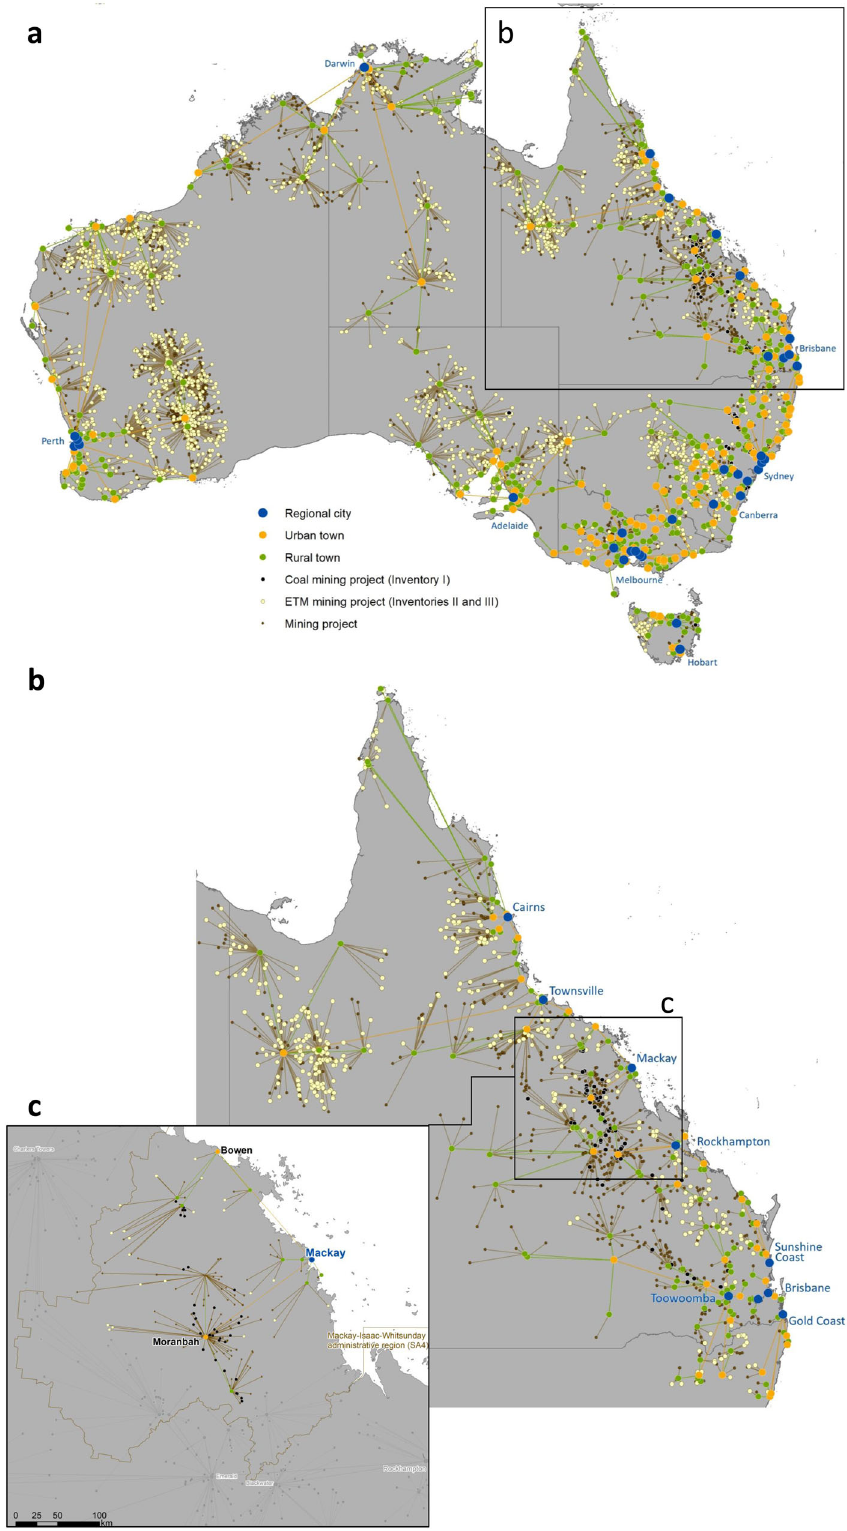
Fig. 4 | Mine-town systems in Australia. a National overview, b detailed geography of the state of Queensland, c Mackay mine-town